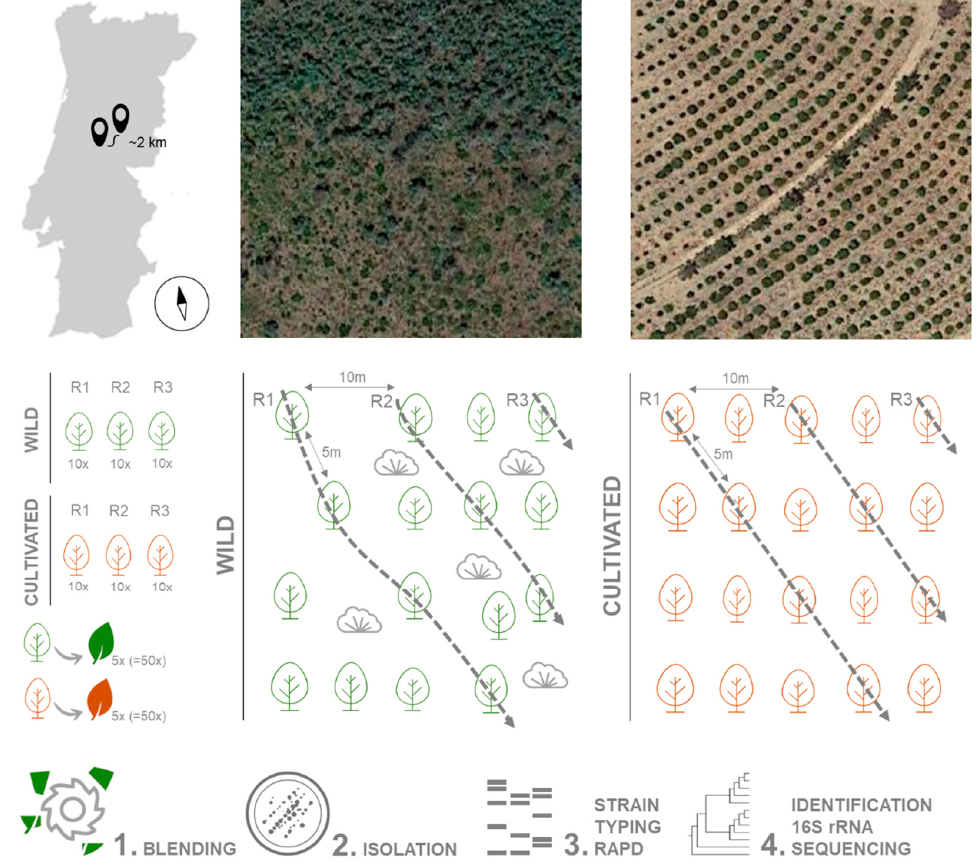
Figure 6. Strategies for sampling, isolation and identification of bacterial endophytes from strawberry tree leaves.